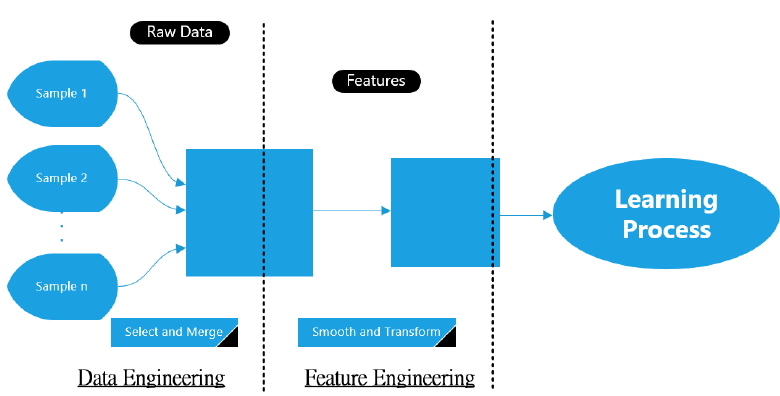
Figure 3. Block diagram of the data pre-processing